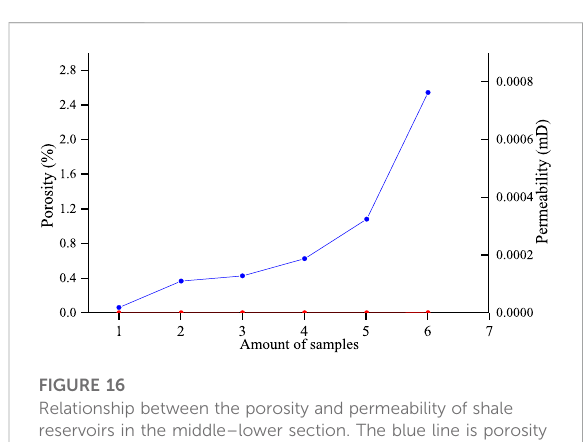
FIGURE 16 Relationship between the porosity and permeability of shale reservoirs in the middle – lower section. The blue line is porosity and red line is permeability.